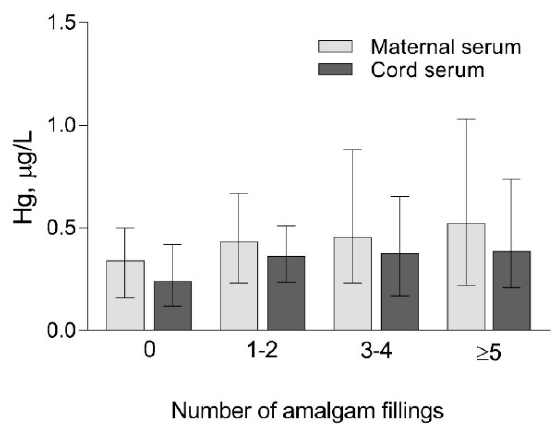
Figure 6. Concentrations of Hg in maternal and umbilical cord serum related to the number of amalgam fillings. Subgroups: 0—no amalgams ( n = 38); 1–2—1 to 2 amalgams ( n = 62); 3–4—3 to 4 amalgams ( n = 46); ≥ 5—5 or more amalgams ( n = 62). Data are presented as median and 25%–75% interquartile range.